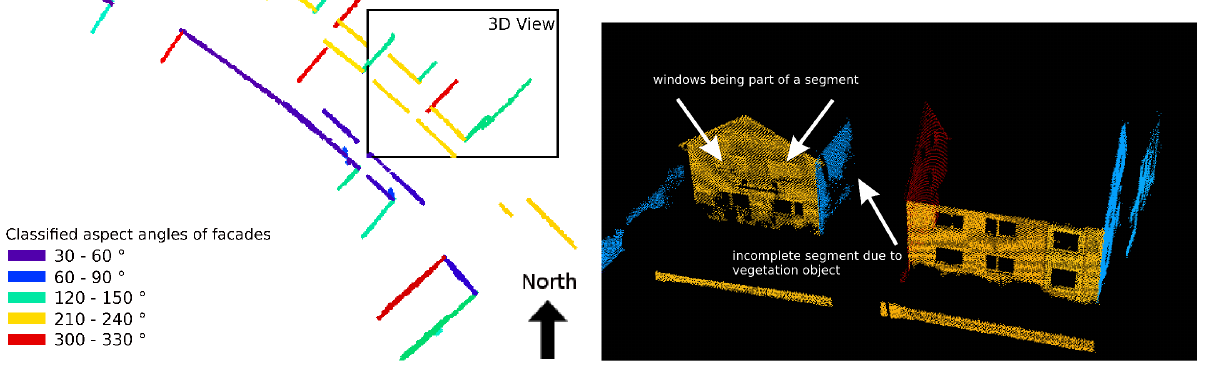
Figure 6. The derived building facade segments are classified according to their aspect angles. Selected examples are shown in 2D (a) and 3D (b) . In some cases segments are incomplete due to occlusion by the nearby objects. Shutters and curtains lead to windows being part of a facade